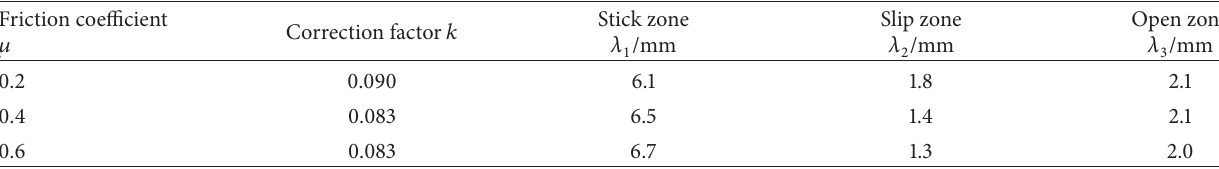
Table 4: Sizes of three zones under different friction coefficients.